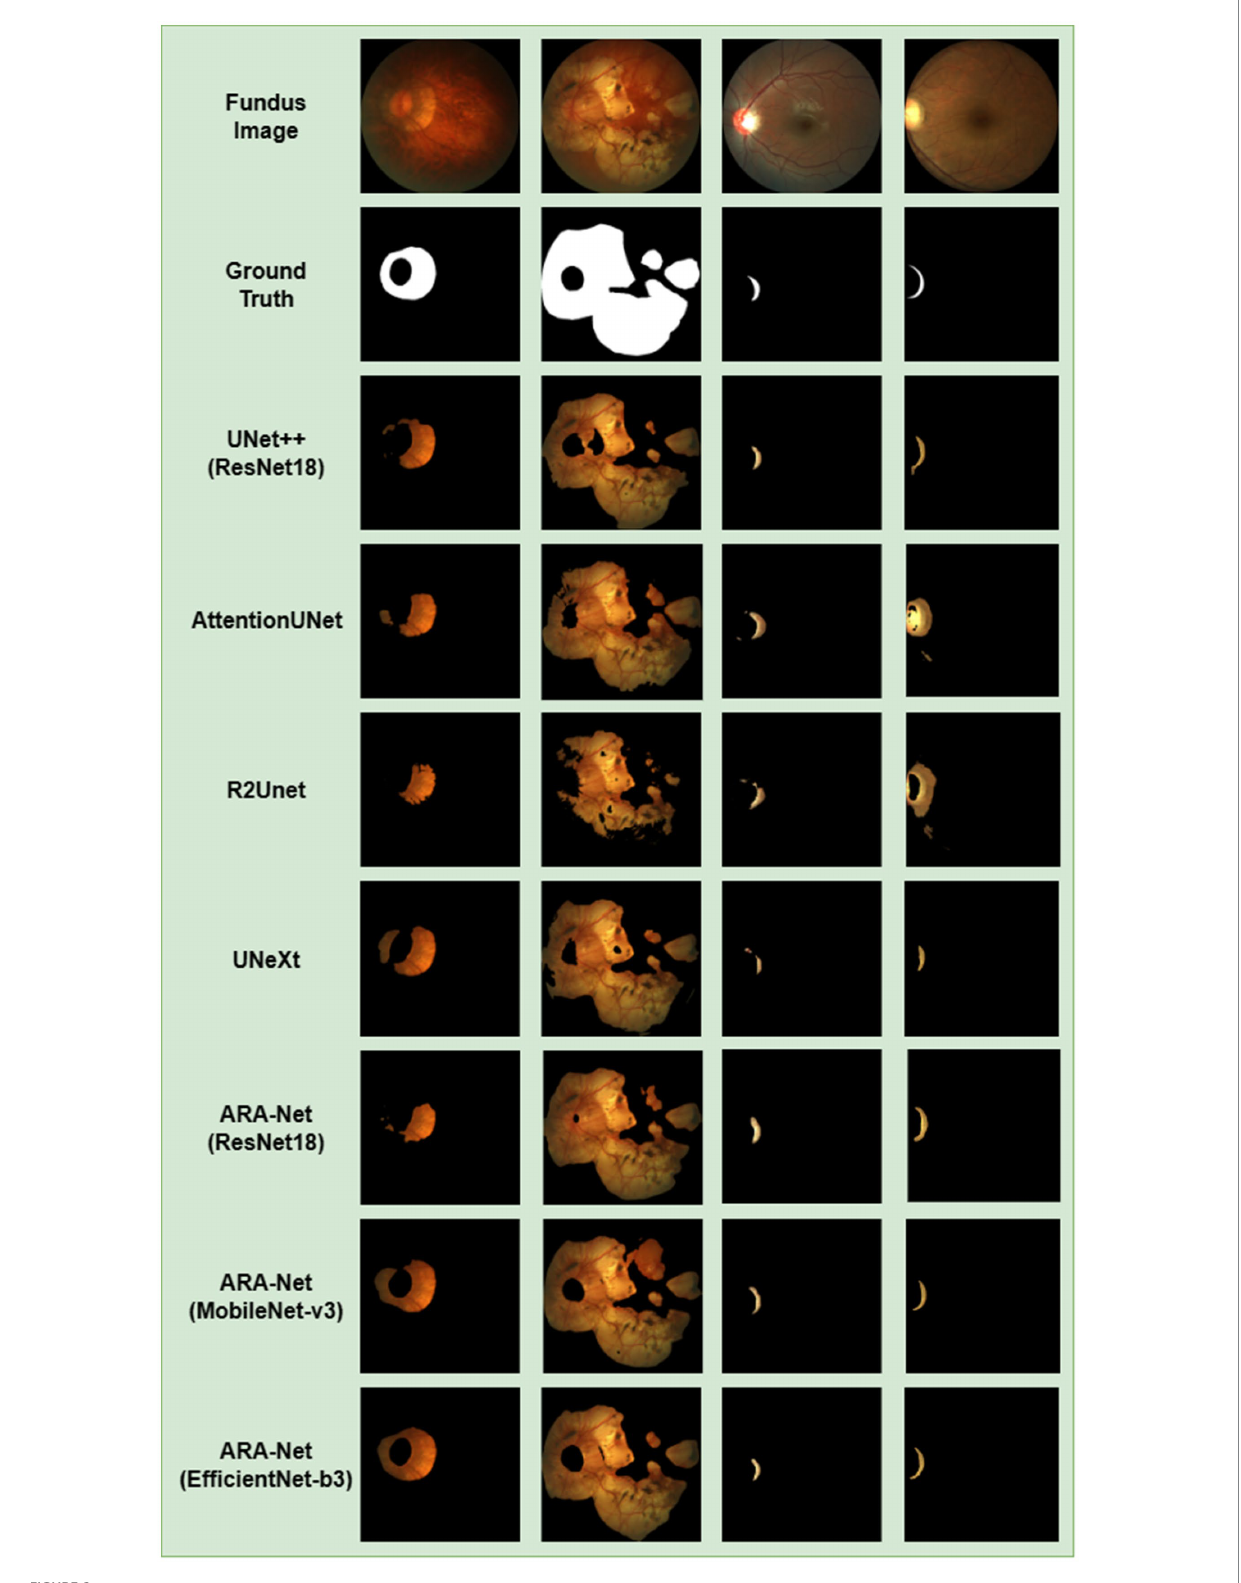
FIGURE 6 Visual segmentation results for myopic parapapillary atrophy. It shows the color fundus input images, the ground truth masks, and the segmentation results for UNet++ (ResNet18), AttentionUNet, R2UNet, UNeXt, ARA-Net (ResNet18), ARA-Net (MobileNet-v3) and ARA- Net